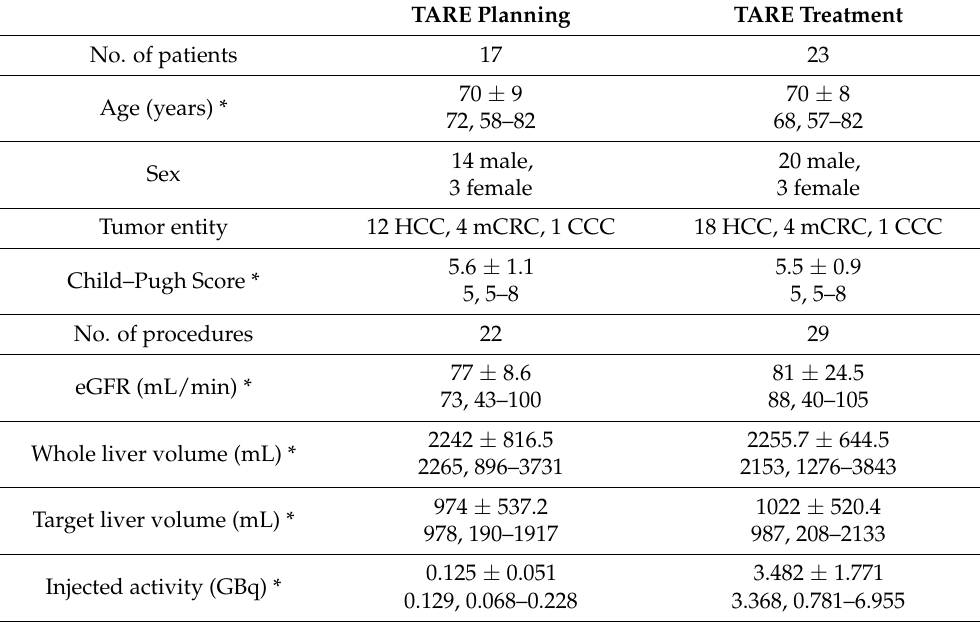
Table 1. Clinical and procedural